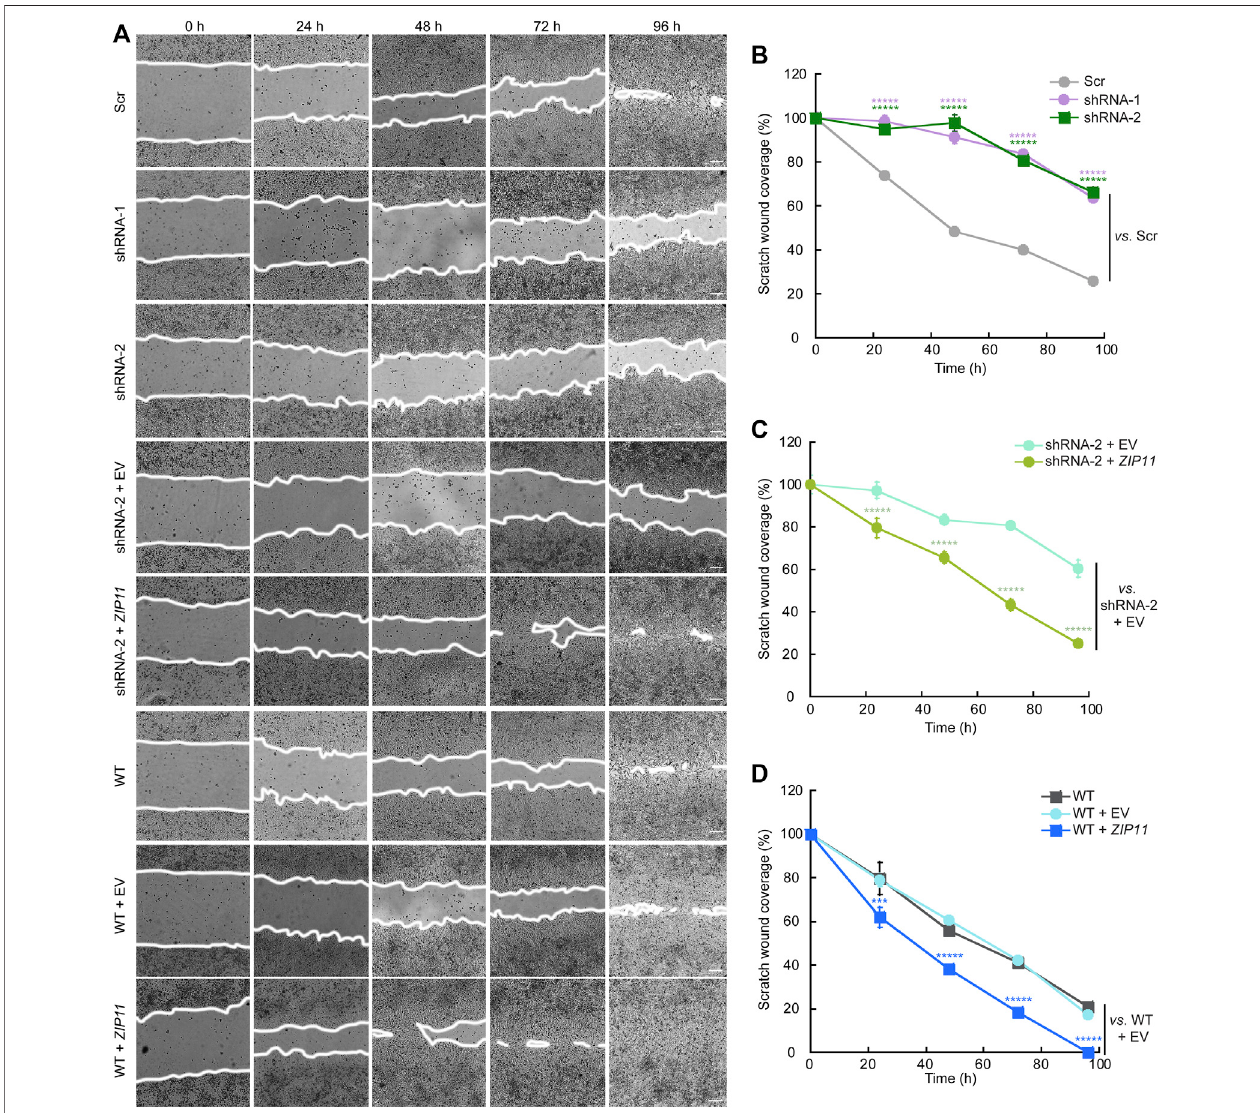
FIGURE7| ZIP11 isrequired fordirectionalmigration ofHeLAcells. (A) Representativelightmicroscopyimages ofthe wound healingassay ofHeLAcells inwhich ZIP11 was KD or overexpressed. Time 0 represents con fl uent monolayer wounds at 0 h and wounds were monitored until the monolayers of WT cells overexpressing ZIP11 became fully closed 96 h after scratching the monolayer. Images are representative of three independent biological replicates. Scale bar: 100 μ m. (B – D) Quanti fi cation of the area of migration over time shown in (A) . (B) HeLa cells expressing Scr and both shRNAs against ZIP11 . (C) Data for the reconstitution of phenotype of ZIP11 KD cells. (D) Migration data of non-transduced WT HeLa cells and those overexpressing ZIP11 or the empty vector (EV). Data represents the means ± SE of three independent biological replicates imaged. ***** p < 0.00001 relative to the samples indicated in the plot.